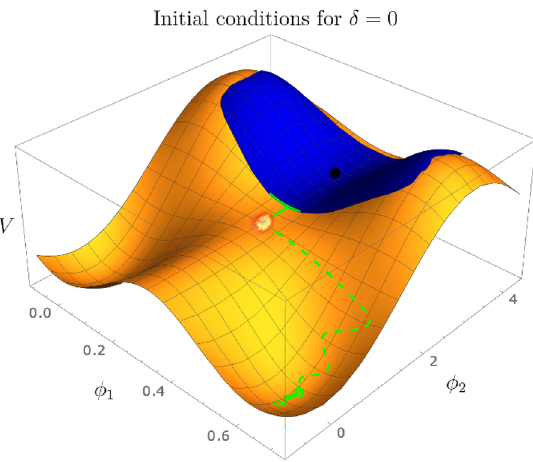
Figure 1 . Hybrid inflation potential driven by the two axions φ 1 and φ 2 , for the choice c 2 = 1 , c 1 = 10 , α = 0 . 01 , corresponding to ˜Λ 4 = 1+ α × Λ 4 ’ 1 . 02Λ 4 . The slow-roll regime is along the 1 − α valley parametrized by the φ 2 direction, while in the φ 1 direction the waterfall is displayed. Black dot: the inflationary saddle point. Blue region: complete region of initial conditions supporting at minimum 60 e-folds of slow-roll inflation. There is no significant initial condition fine-tuning present in this model. Solid green: slow-roll part of a sample inflationary trajectory providing 60 e-folds of slow-roll inflation before reaching the waterfall critical point φ 2 ,cr . Fire ball: explosive growth of tachyonic quantum fluctuations with loss of classical rolling description. Dashed green: would- be classical waterfall evolution neglecting quantum fluctuations for the same sample inflationary trajectory after crossing the waterfall critical point φ 2 ,cr